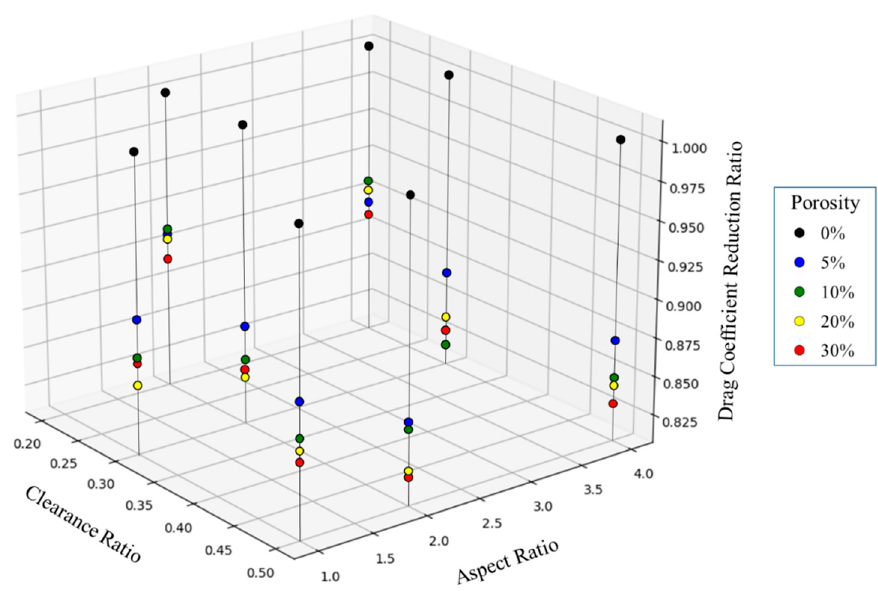
Figure 9. Drag coefficient reduction ratio of perforated road sign by porosity.